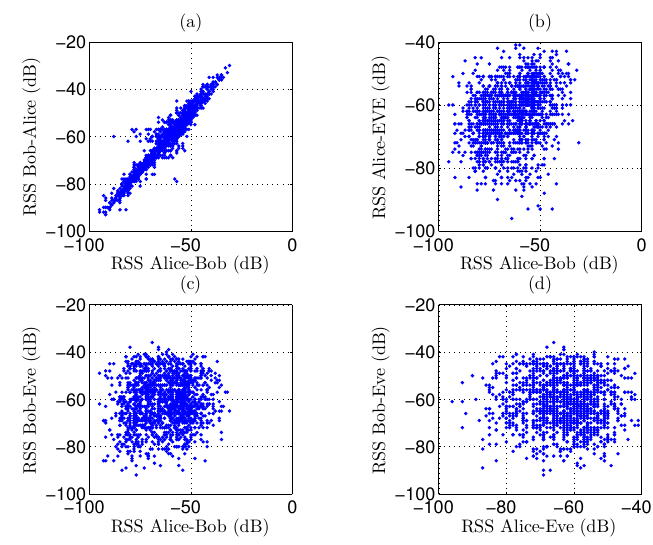
Figure 5. Scatterplots for 1500 recorded RSS (Received Signal Strength) channel samples in scenario 1, displaying high correlation for the legitimate parties and very low correlation for the eavesdropper. ( a ) Correlation for Bob-to-Alice versus Alice-to-Bob signals; ( b ) Correlation for Alice-to-Eve versus Alice-to-Bob signals; ( c ) Correlation for Bob-to-Eve versus Alice-to-Bob signals; ( d ) Correlation for Bob-to-Eve versus Alice-to-Eve signals.